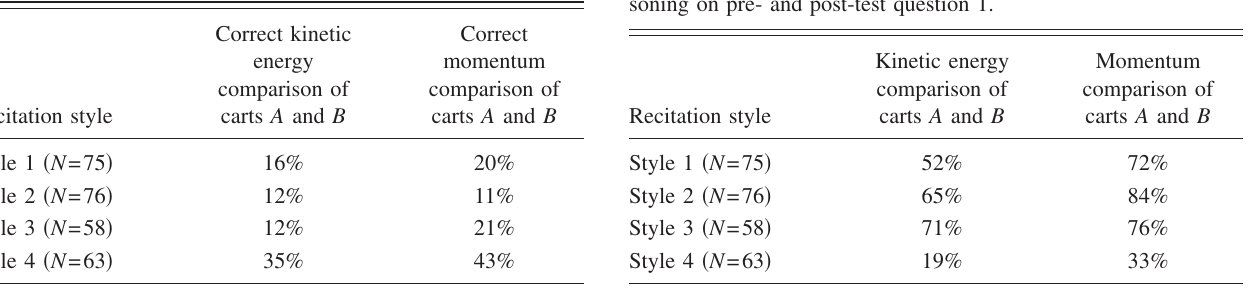
TABLE III. Student performance on post-test question 1.